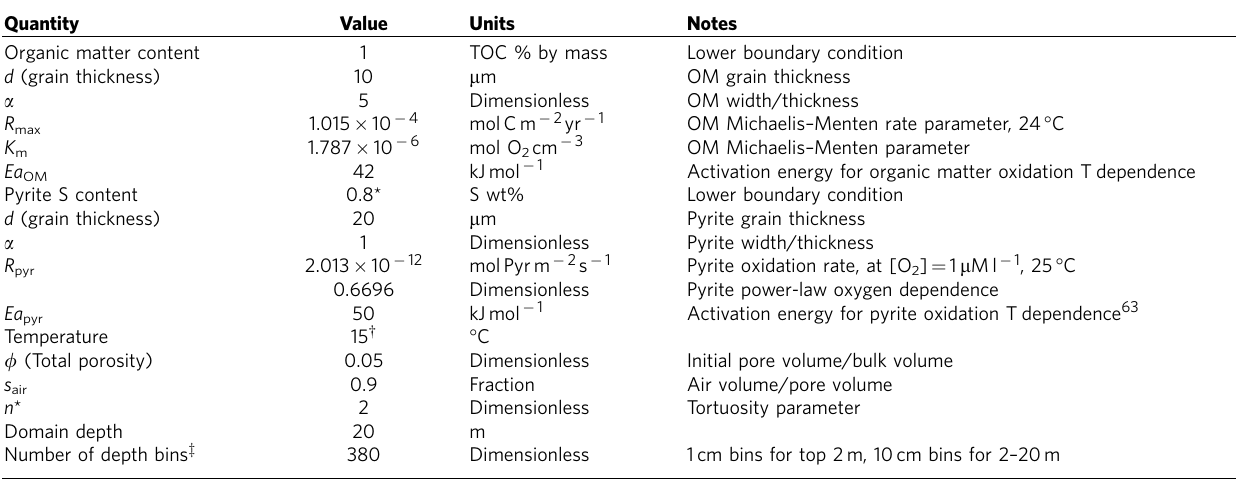
Table 2 | Parameters for the land-surface oxidative weathering model (from Bolton et al. 32 ‘default model run’ except where